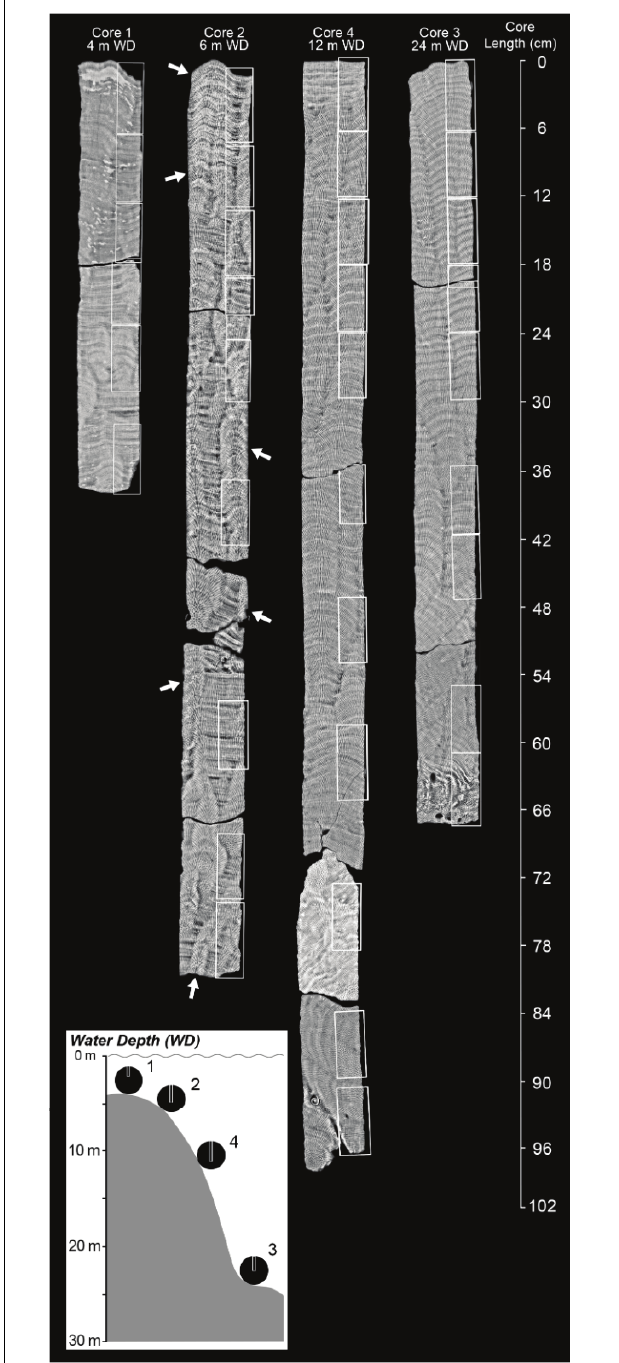
FIGURE 2 | Maximum intensity projection of microcomputed tomography (MicroCT) from 2 mm-thick equivalent slices (a total of 28 slices each having 69 µ m isodiametric voxel size per slice) oriented vertically through the center of four Porites cores from Myrmidon Reef, Great Barrier Reef, Australia. Cores broke into segments while drilling and are shown in their original vertical alignment. White boxes indicate the position within each core from which 35 petrographic thin sections were prepared and analyzed. The total length of core covered by thin sections is ∼ 2.1 meters. Coral skeletal density